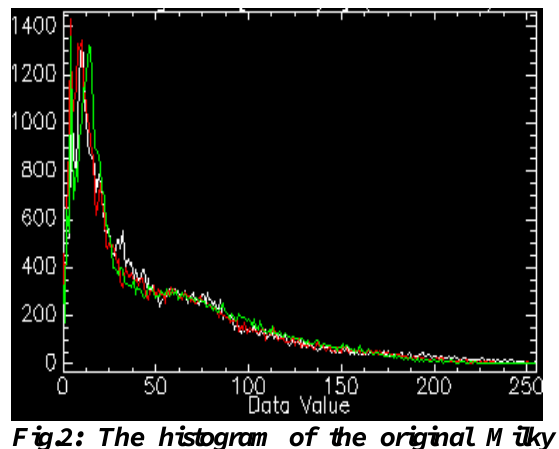
Fig.2: The histogram of the original Milky Way galaxy (three